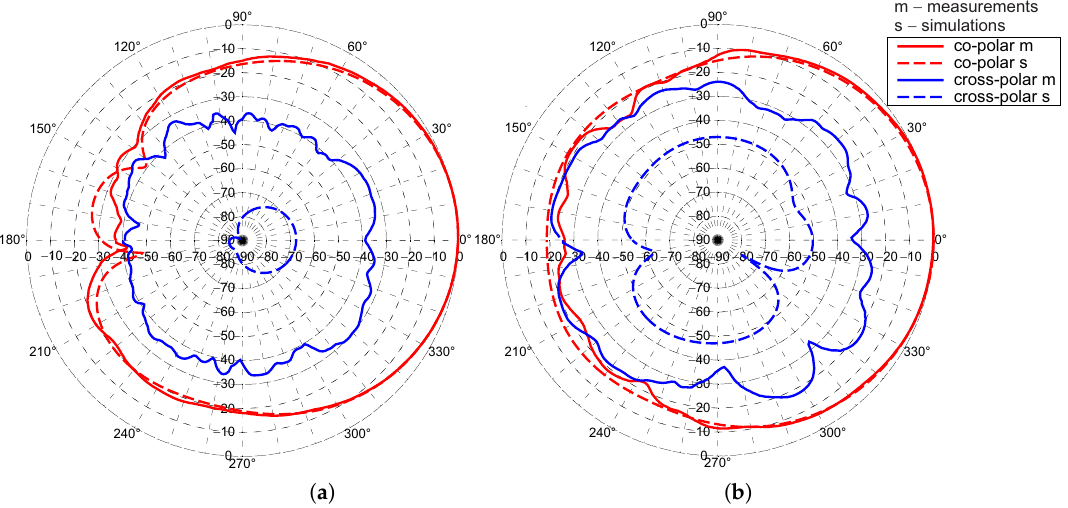
Figure 20. Normalised co-polar and cross-polar radiation patterns measured and simulated at 5.5 GHz on the principal H-plane for: ( a ) port 1; ( b ) port